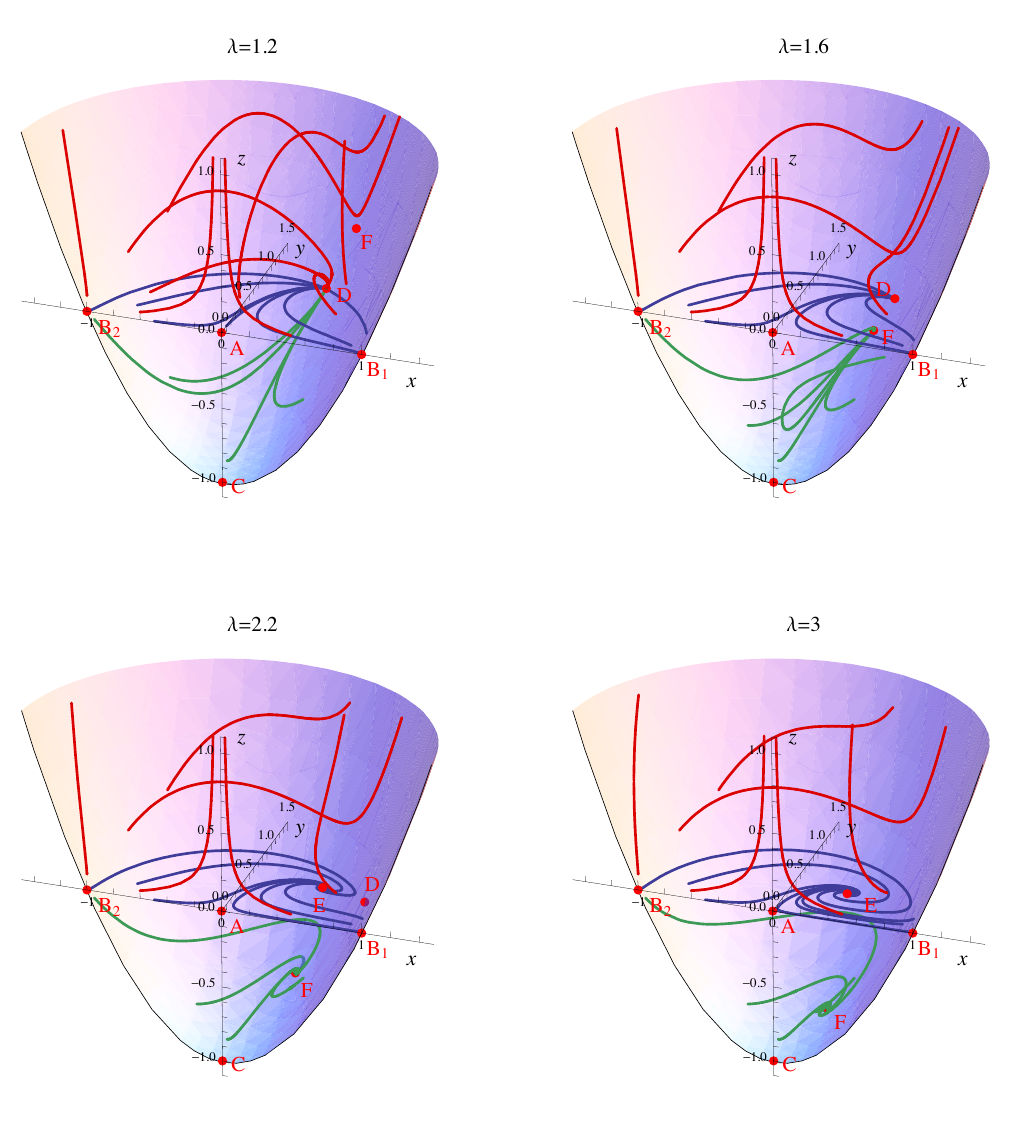
Figure 2. Phase spaces for four different λ and w M = 0. Valid phase space is limited by the parabolical surface: all valid trajectories lie above it. Trajectories in the x − y plane (where z = 0) are shown in blue. Green trajectories lie between this plane and the parabolic surface. Since z = − Ω K = K/ ( a 2 H 2 ), green trajectories represent part of the phase space with negative curvature. Red trajectories are bounded to the part of the space where z > 0 which corresponds to K > 0. Point E lies under the parabolic surface for the first two cases, so it’s not shown in the